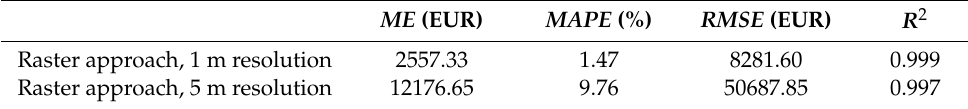
Table 6. Statistical analysis of LATIS tool with respect to FLIAT tool for building blocks of the Belgian